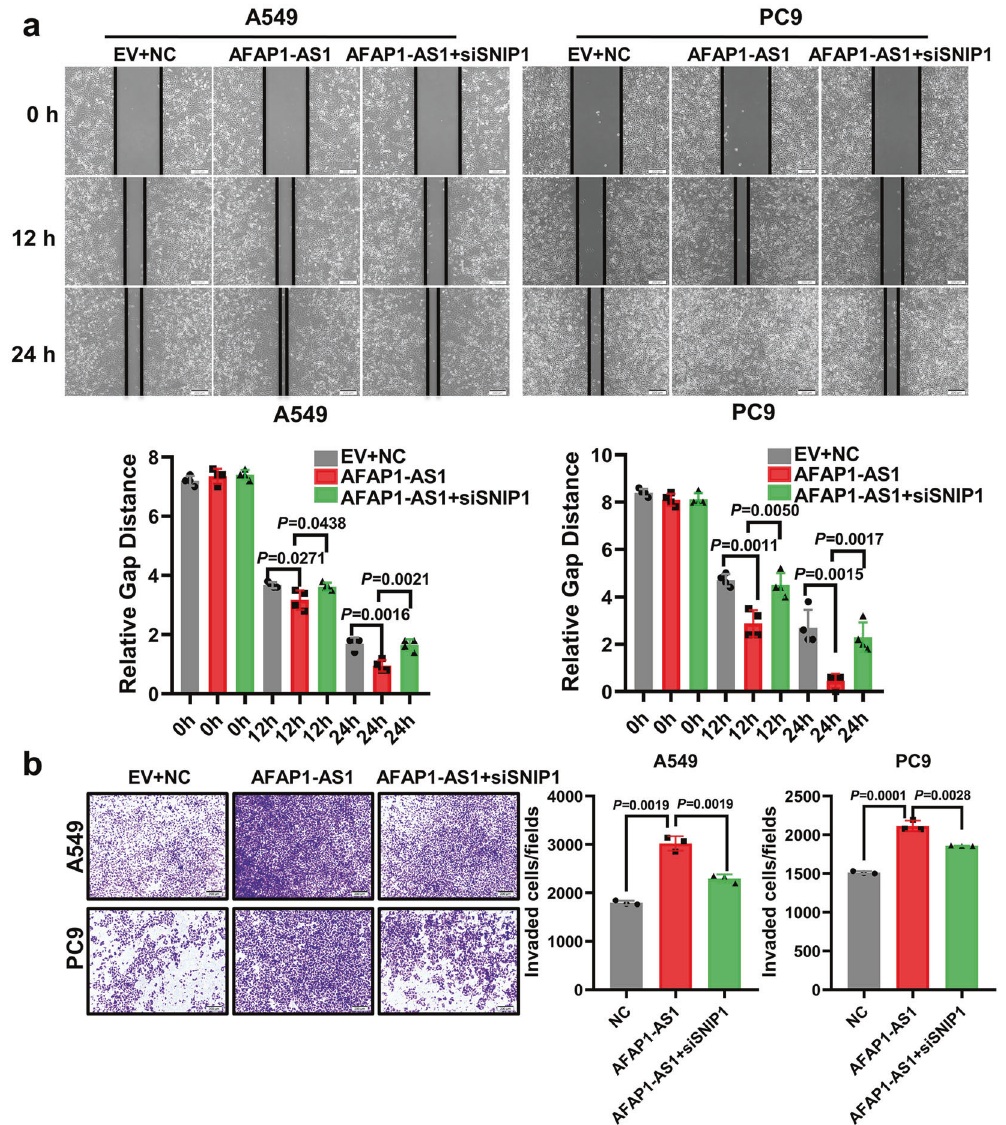
Fig. 4 AFAP1-AS1 promotes lung cancer cells migration and invasion through SNIP1. a Representative images from migration assays of A549 and PC9 cells transfected with scrambled siRNAs and the empty vector (EV + NC), AFAP1-AS1, or co-transfected with the AFAP1-AS1 overexpression plasmid and the two siRNAs pool targeting SNIP1. AFAP1-AS1 promoted cells migration, whereas knockdown of SNIP1 decreased the effect of AFAP1-AS1 (Scale bar: 200 μ m). b Representative images of the invasion assays in A549 and PC9 cells transfected with scrambled siRNAs and the empty vector (EV + NC), the AFAP1-AS1 ovexpression plasmid or co-transfected with the AFAP1-AS1 overexpression vector and the pool of two siRNAs targeting SNIP1. AFAP1-AS1 promoted the invasion of the two cell lines, whereas knockdown of SNIP1 expression decreased the effect of AFAP1-AS1 (Scale bar: 200 μ m). All experiments were repeated at least three times. Data are presented as the means ± SD guiding effect. It functions as a chaperone molecule through experiment for SNIP1 and c-Myc proteins were also performed in combining with a protein and translocates a protein complex to a A549 and PC9 cell lines and knockdown of AFAP1-AS1 weakened speci fi c DNA sequence, thereby regulating the transcription of the interaction between endogenous c-Myc and SNIP1 proteins downstream target genes. AFAP1-AS1 might upregulate c-Myc and (Supplementary Fig. S7). Immuno fl uorescence also revealed that promotes the transcriptional activity target gene downstream of c- the colocalization between SNIP1 and c-Myc proteins decreased Myc, ZEB1, ZEB2, and SNAIL, by promoting the binding of SNIP1 signi fi cantly after AFAP1-AS1 knockdown (Fig. 7b). These suggest and c-Myc. The ChIP experiments according to ZEB1, ZEB2, and that AFAP1-AS1 mediates the interaction between SNIP1 and SNAIL genes showed that c-Myc binds to the promoters of ZEB1, c-Myc, serving as a molecular guide. ZEB2 and SNAIL genes and promotes their transcription (Fig. 8a). The expression of ZEB1, ZEB2, and SNAIL genes at both AFAP1-AS1 promotes epithelial-mesenchymal transition (EMT) by of the mRNA and protein levels was signi fi cantly downregulated interacting with SNIP1 to upregulate c-Myc after AFAP1-AS1 or SNIP1 knockdown in A549 and PC9 cell lines. c-Myc can activate the transcription of EMT-related molecules ZEB1, Upregulation of AFAP1-AS1 or SNIP1 induced the expression levels ZEB2, and SNAIL. Several studies have shown that lncRNA has a Signal Transduction and Targeted Therapy (2021)